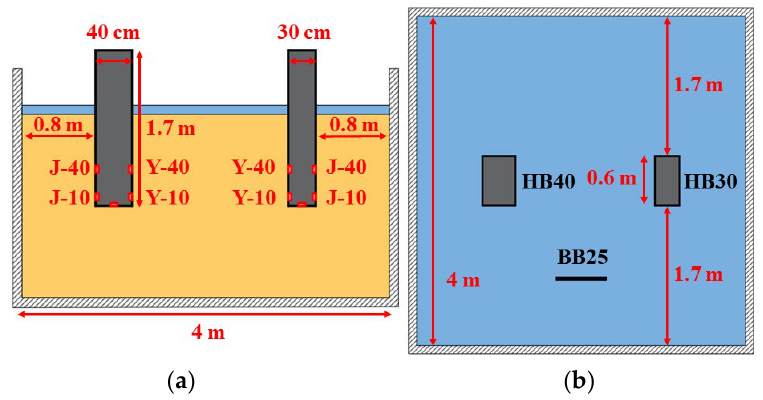
Figure 5. Schematic diagram of the sink-test model and sensor arrangement: ( a ) Elevation; ( b ) Platform.